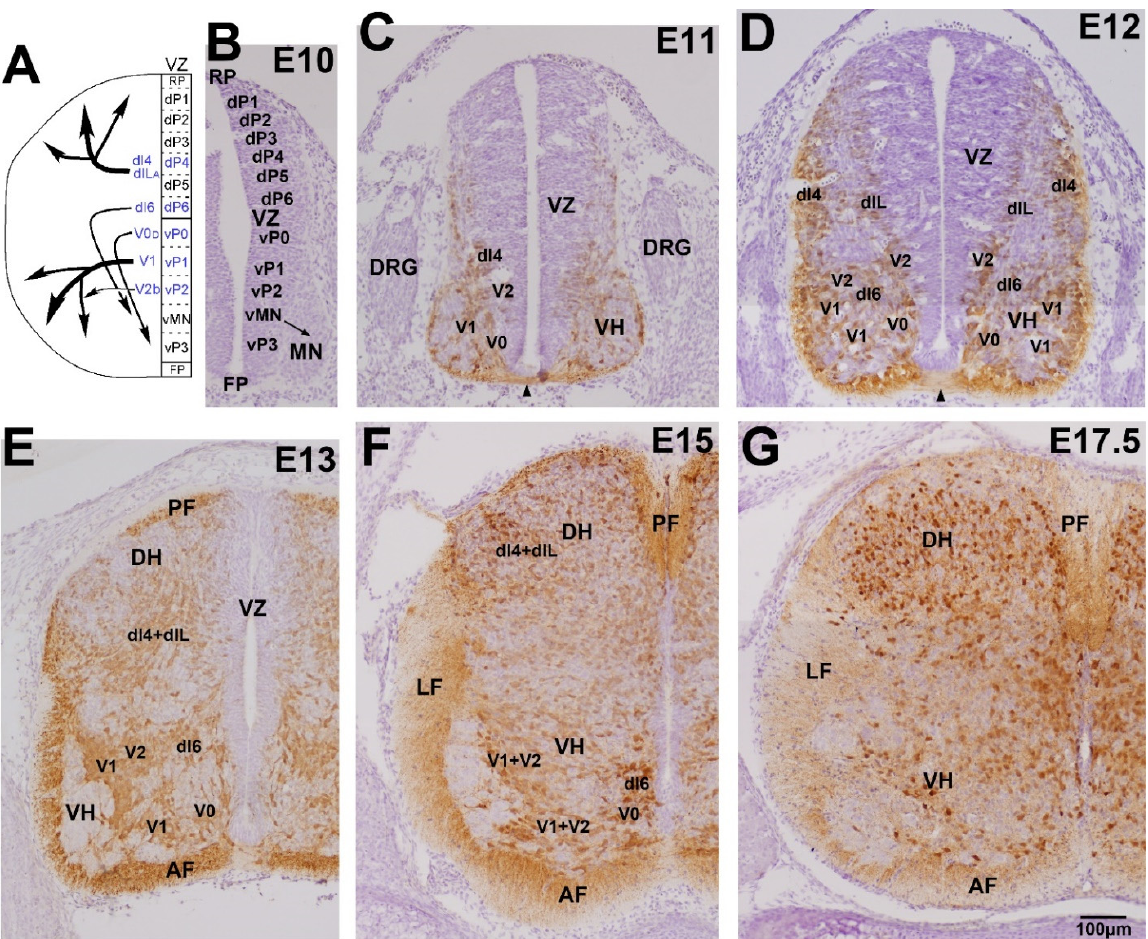
Figure 3. Developmental localization of GABAergic neurons in the spinal cord. ( A ) Schematic illustration of the origin of GABAergic neurons and their migration routes. GABAergic neurons are derived from six classes (V0D, V1, V2b, dI6, dI4, and dIL) that arise from five domains (vP0, vP1, vP2, dP6, and dP4). Each class of GABAergic neurons migrates their own routes and settle in distinct laminae. ( B – G ) Immunohistochemical analysis of GFP in the developing GFP-GAD knock-in mouse spinal cord. GABAergic neurons were absent at E10 ( B ) and appeared at E11 ( B ), and expanded their localization during embryonic development in the ventral-to-dorsal direction ( D – G ). In contrast to the mature spinal cord (Figure 1B), many GABAergic neurons were detected homogeneously in the dorsal and ventral horn of the embryonic spinal